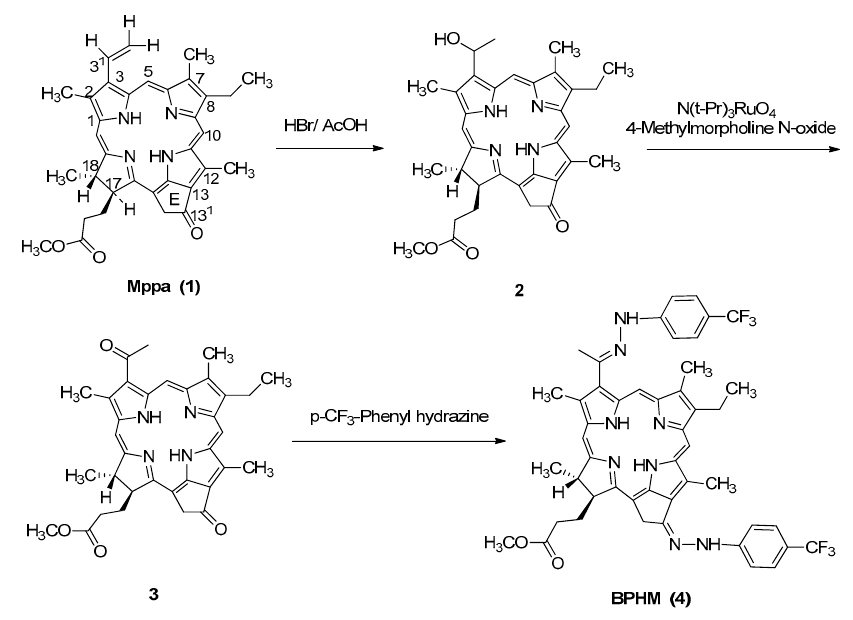
Scheme 1. The synthesis of BPHM (C-3 1 ,13 1 -Bisphenylhydrazone).